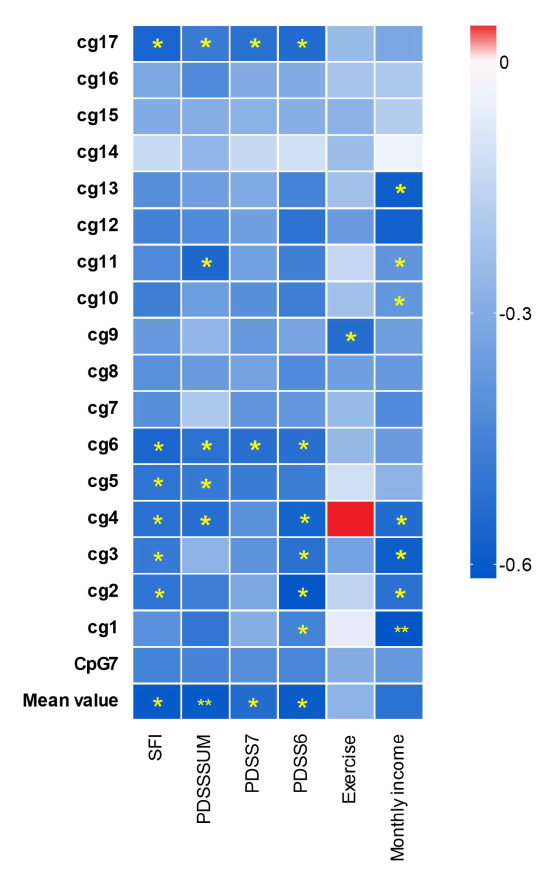
FIGURE3 Differential hTERT methylation and the clinical characteristics in panic disorder. The x -axis shows the clinical characteristics of PD patients; the y -axis shows the hTERT genes average methylation, the different methylation of the gene CpG islands and cg sites. The color of the box shows the Pearson correlation coefficient (red for positive correlation, blue for negative correlation). The color intensity represents the degree of enrichment. “*” indicates enrichment is statistically significant ( p < 0.05), “**” indicates p <